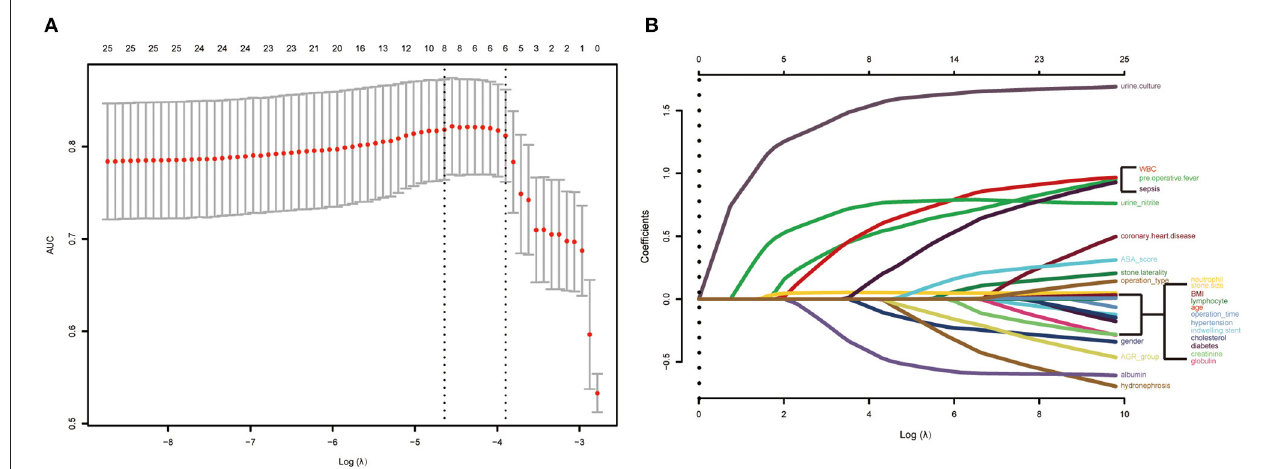
FIGURE 2 | Risk predictors selection using the least absolute shrinkage and selection operator (LASSO) logistic regression model. (A) Optimal predictor (lambda) selection in the LASSO model with fivefold cross-validation by minimum criteria. The area under the receiver operation characteristic curve was plotted vs. log (lambda). Dotted vertical lines were drawn at the optimal values by using the minimum criteria and the 1 SE of the minimum criteria; (B) LASSO coefficient profiles of the 25 predictors. A coefficient profile plot was developed according to the log (lambda) sequence. A vertical line was drawn at the value selected with fivefold cross-validation, where optimal lambda resulted in 8 predictors with nonzero coefficients (lambda = 0.009629).